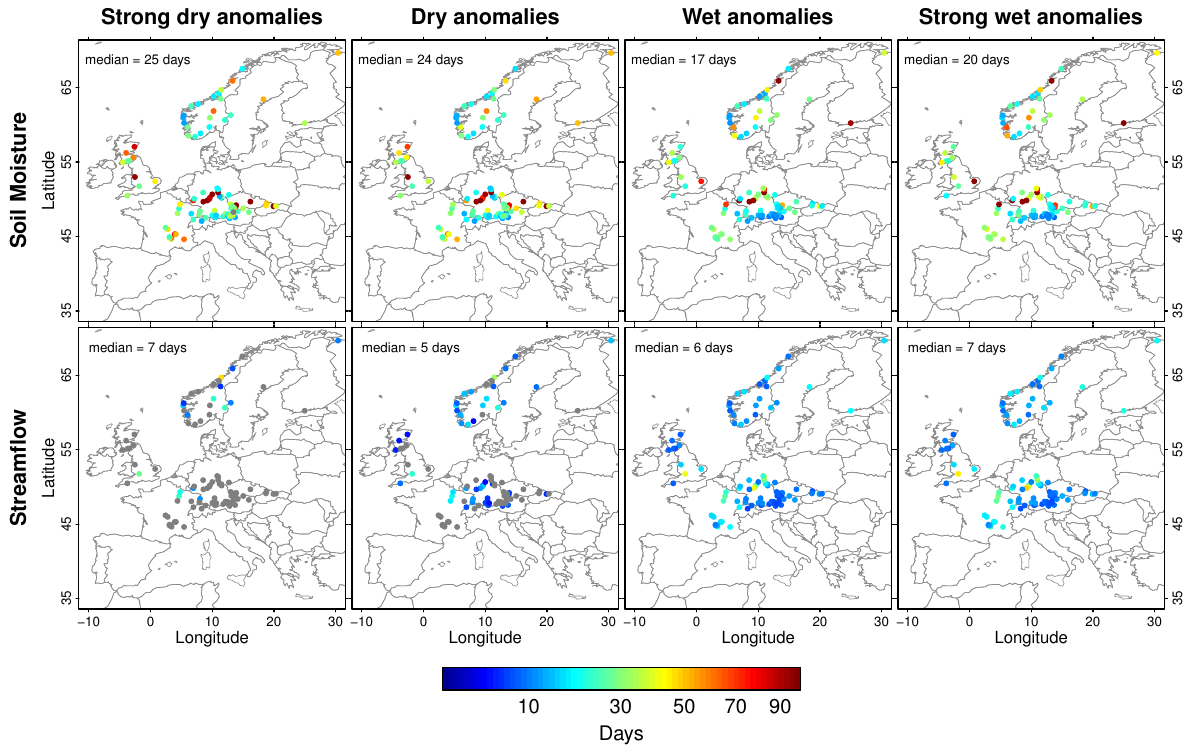
Fig. 10. Overview of mean durations to recover from (very) dry/wet conditions (1.33 and 1.66 standard deviations away from the respective daily mean of the respective quantity) to normal conditions ( ± 1 standard deviation around the mean) for (modelled) soil moisture and streamflow. The results are based on daily data. In the upper left corner of each plot the median over all selected catchments is displayed. Gray colour indicates that no persistence can be computed because the applied threshold is almost never